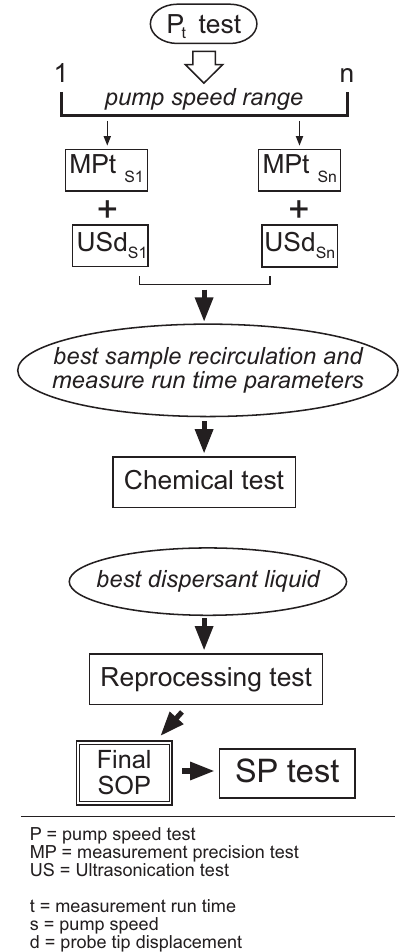
Fig. 2. Flow chart illustrating the main steps that constitute the pro- posed workflow to select the most appropriate operating procedure for analyzing granular materials. See text for